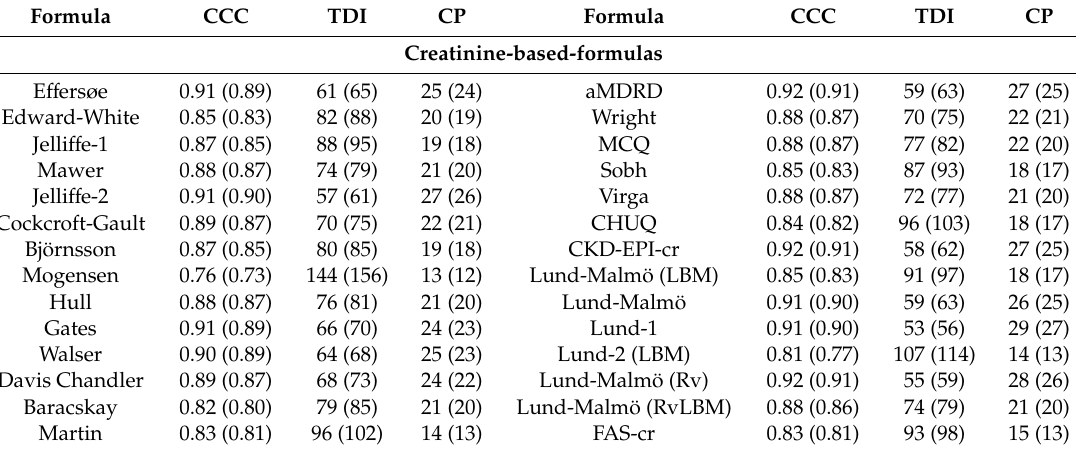
Table 2. Analysis of agreement between estimated glomerular filtration rate (GFR) using creatinine- and cystatin C–based formulas and measured GFR using plasma clearance of iohexol for the overall population of the